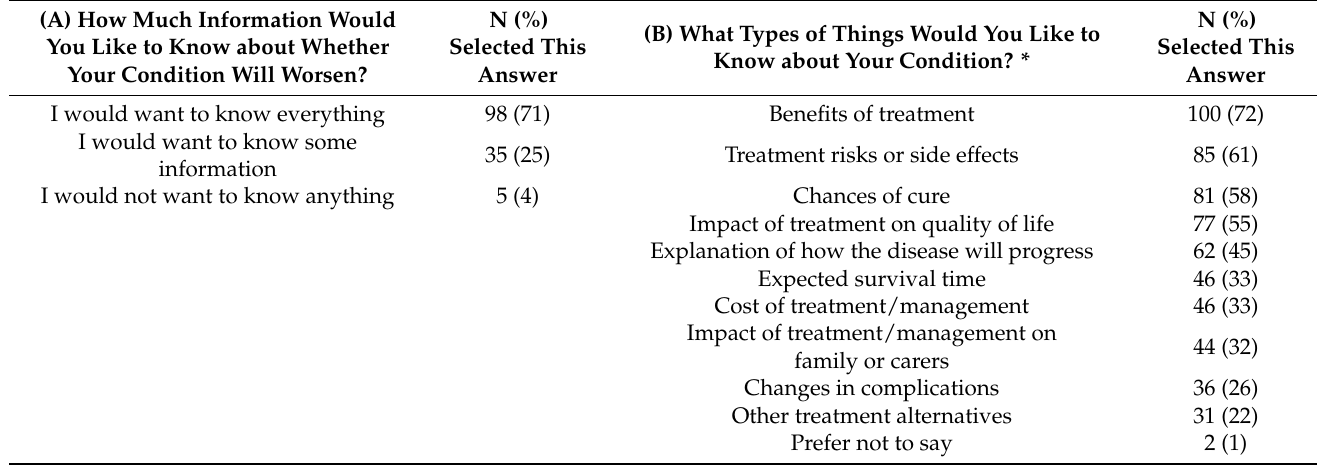
Table 3. Depth and type of prognostic information that survey respondents wanted to